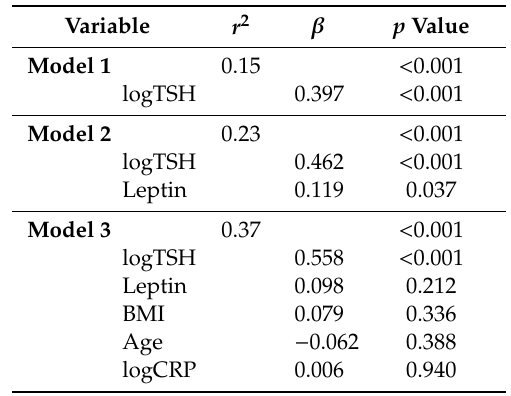
Table 3. Multiple regression analysis with logGDF11 as dependent